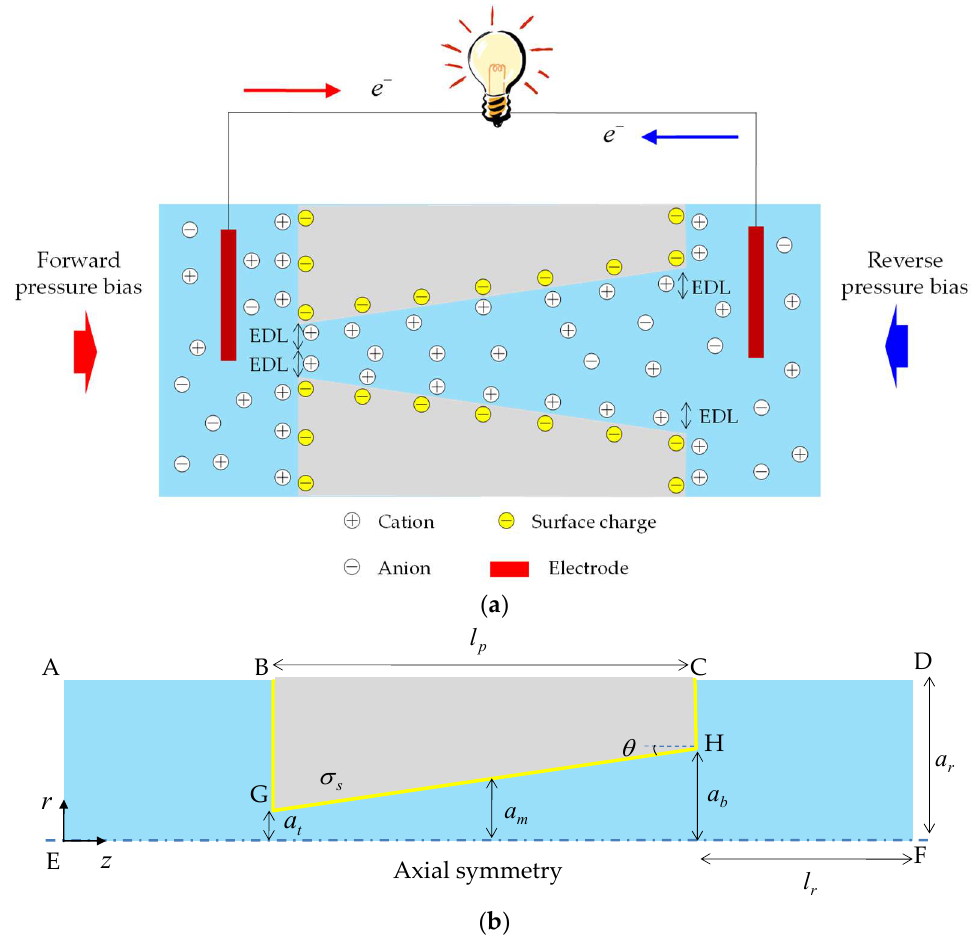
Figure 1. ( a ) Schematic representation of electrokinetic power generation under a forward/reverse pressure bias in a conical nanopore bearing negative surface charges. ( b ) Schematic illustration of 2D axisymmetric geometry of a conical nanopore used in the computation.